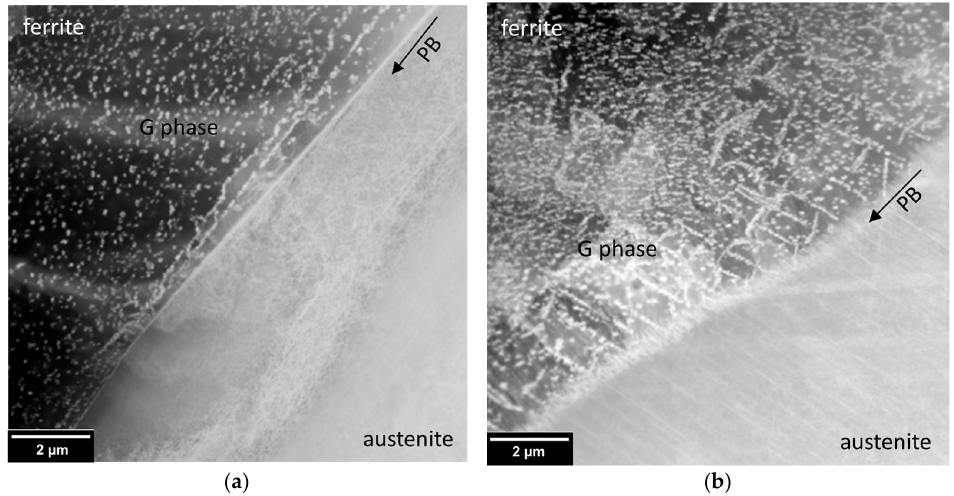
Figure 7. ADF-STEM images of the microstructure and the dislocation arrangement after thermomechanical fatigue in the temperature range from 300 to 600 °C in ( a ) IP condition and ( b ) OP condition. G phase appears in small white particles.